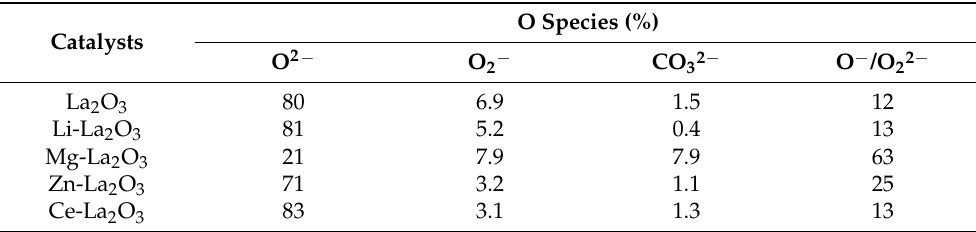
Table 2. Surface compositions and oxidation states O species over X-La 2 O 3 catalysts derived from XPS